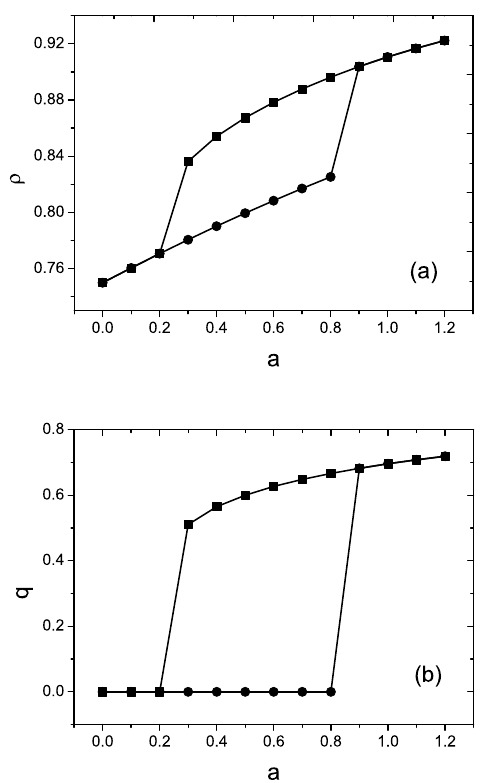
Figure 5. PS case. First order transition as a function of a ≡ µ / (cid:101) for fixed θ = 1.69. ( a ) occupancy and ( b ) orientational order parameter. Circles: disordered solution, squares: ordered solution. Lines are just guides to the